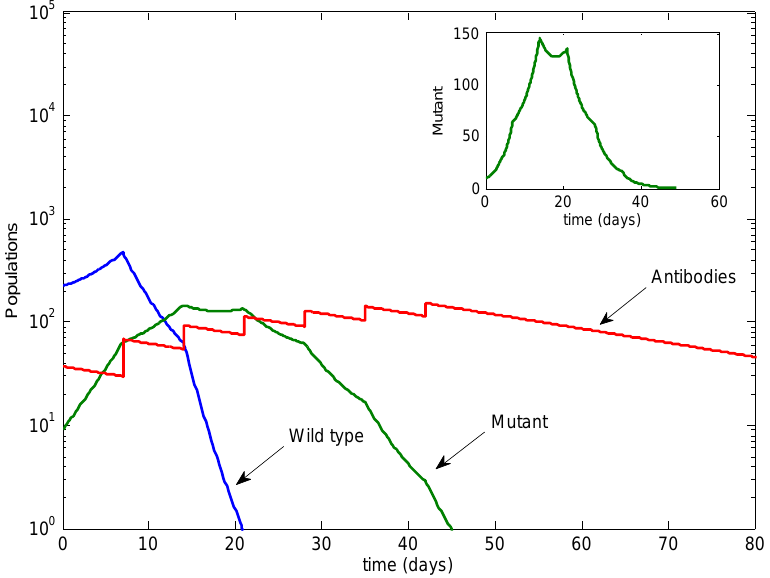
Figure 5. The case with four additional infusions. Both the wild type and mutant are cleared. We then investigated the case of control of heterologous infection by NAbs (i.e., infection with mutant virus but with infusions of antibodies against wild type as earlier) by setting W ( 0 ) = 0 and M ( 0 ) > 0. In this case, we determined that seven antibody infusions are likewise required for viral eradication. See Figure